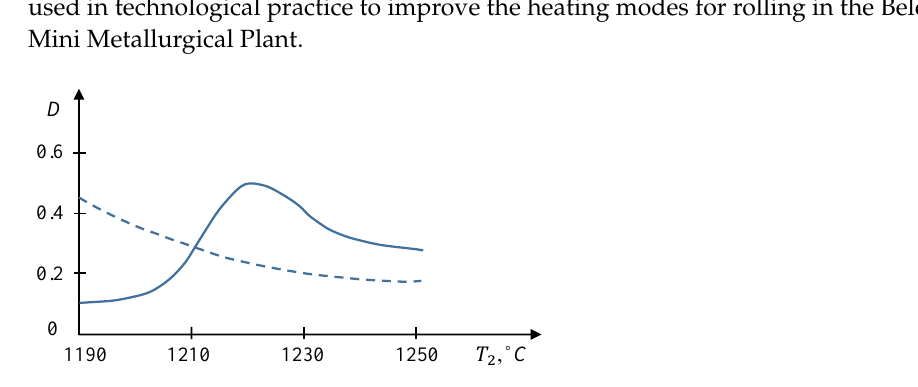
Figure 3. Distribution of the global criterion in the vicinity of the found optimum and the center of the